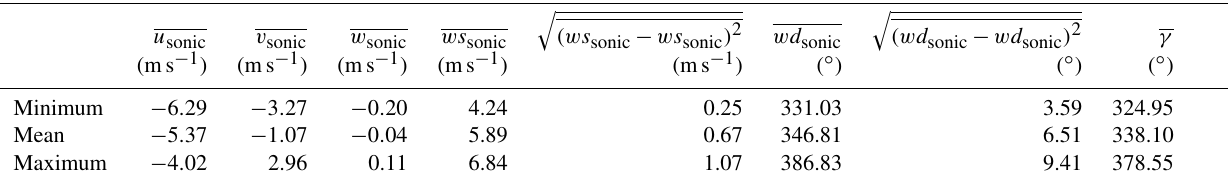
Table 2. Summary statistics of the five 10min bins used for the validation study of waked data. Data shown correspond to the sonic anemome- ter at 31.9m. The values ws sonic and wd sonic are the horizontal wind speed and wind direction, respectively. The value γ is the turbine yaw heading, which corresponds to clockwise rotation in the reference frame of Fig.